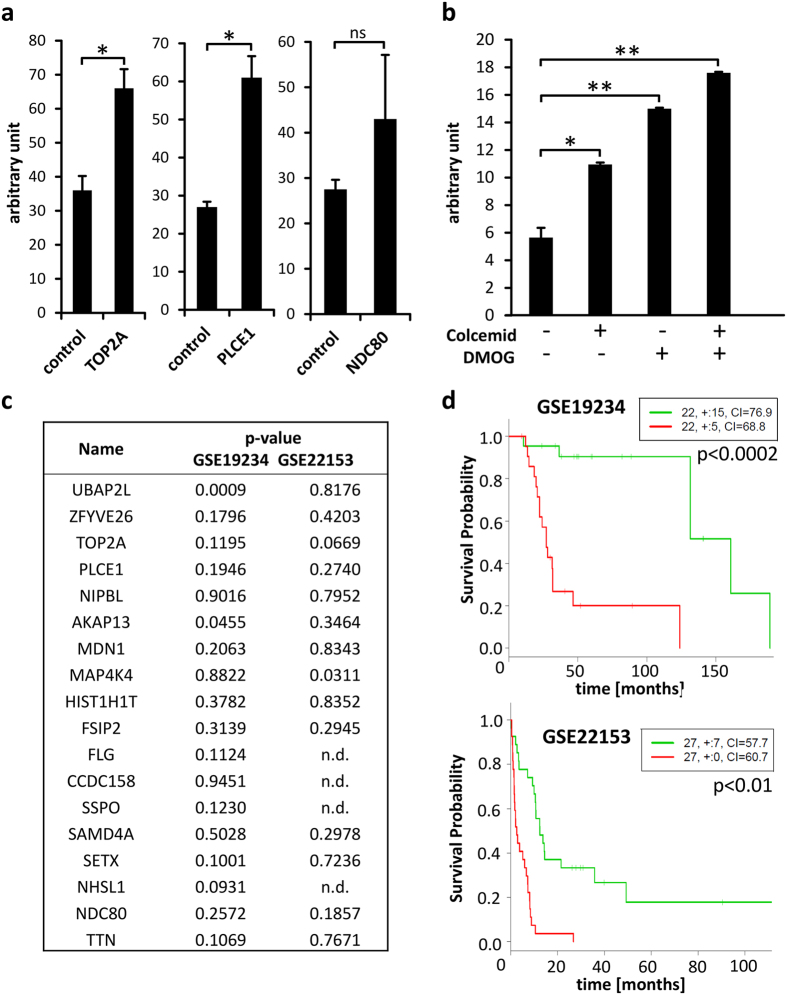
MHA-3 target validation.(a) ELISA plate was coated with recombinant TOP2A, PLCE1 and NDC80, detected by MHA-3 and compared to BSA control. (b) MCM1 cells were treated with either colcemid or DMOG or both and subjected to ELISA measurement by MHA-3 incubation. All experiments were performed in triplicates and unpaired t test was used to compare the results (*p < 0.05 and **p < 0.01). Error bars represent standard error of mean. (c) p-values are given for Kaplan Meier analysis in two independent patient cohorts (GSE19234 and GSE22153) for each of the 18 identified proteins. (d) Kaplan Meier curves from SurvExpress analysis showing the p-value after log-rank testing for all identified target proteins combined. Concordance Index was 83.68 and 71.58 for GSE19234 and GSE22153, respectively. Red and green curves denote high- and low-risk groups, respectively.